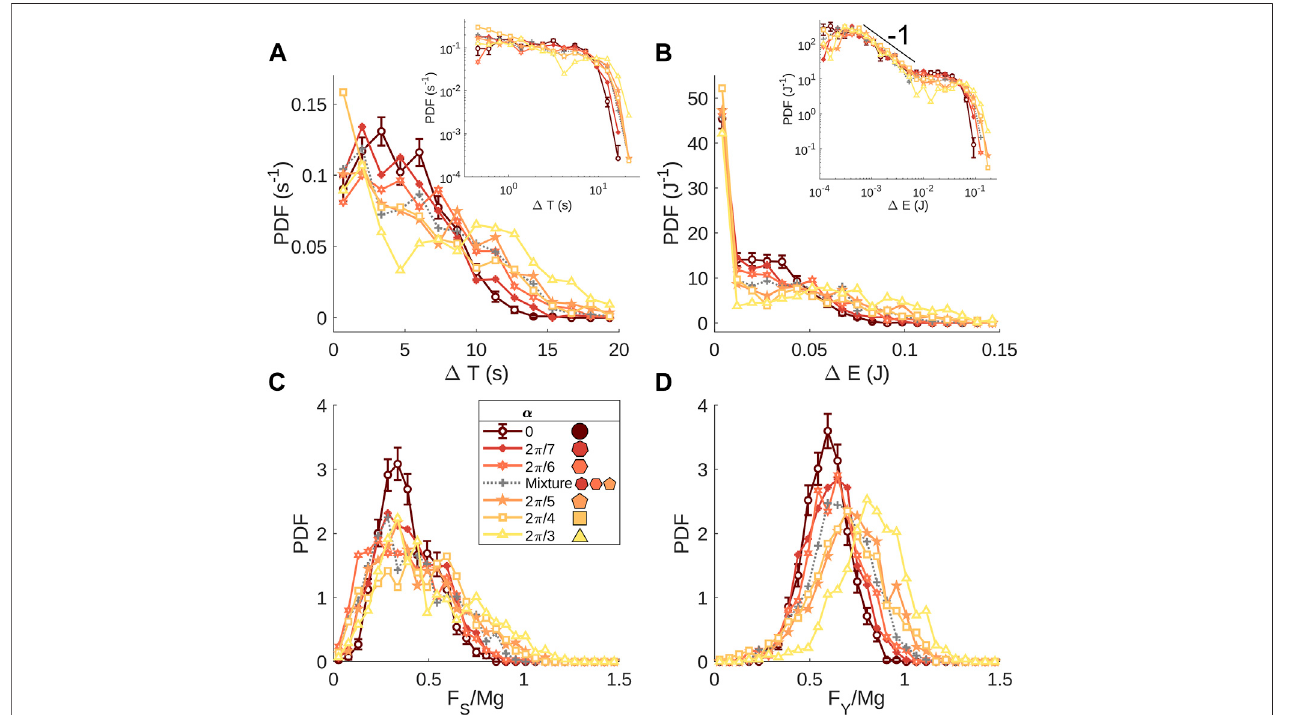
FIGURE 6 | PDFs of (A) the duration of sticking periods Δ T , (B) the energy released in slip events Δ E , (C) the force F S on the slider at the start of a sticking period, and (D) theforce F Y attheendofastickingperiod,whenthematerialsstartstoyield.Insets in (A,B) :Probabilitydensityfunctionsof Δ T and Δ E ,respectively,onalog-log scale; the black line has a slope of − 1. Error bars for disk ( α = 0) data are representative of the scale of error bars on other data sets (not shown).